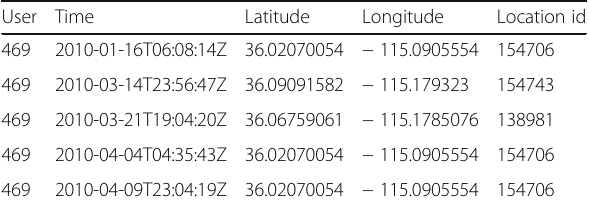
Table 2 The samples of the user check-in data User Time